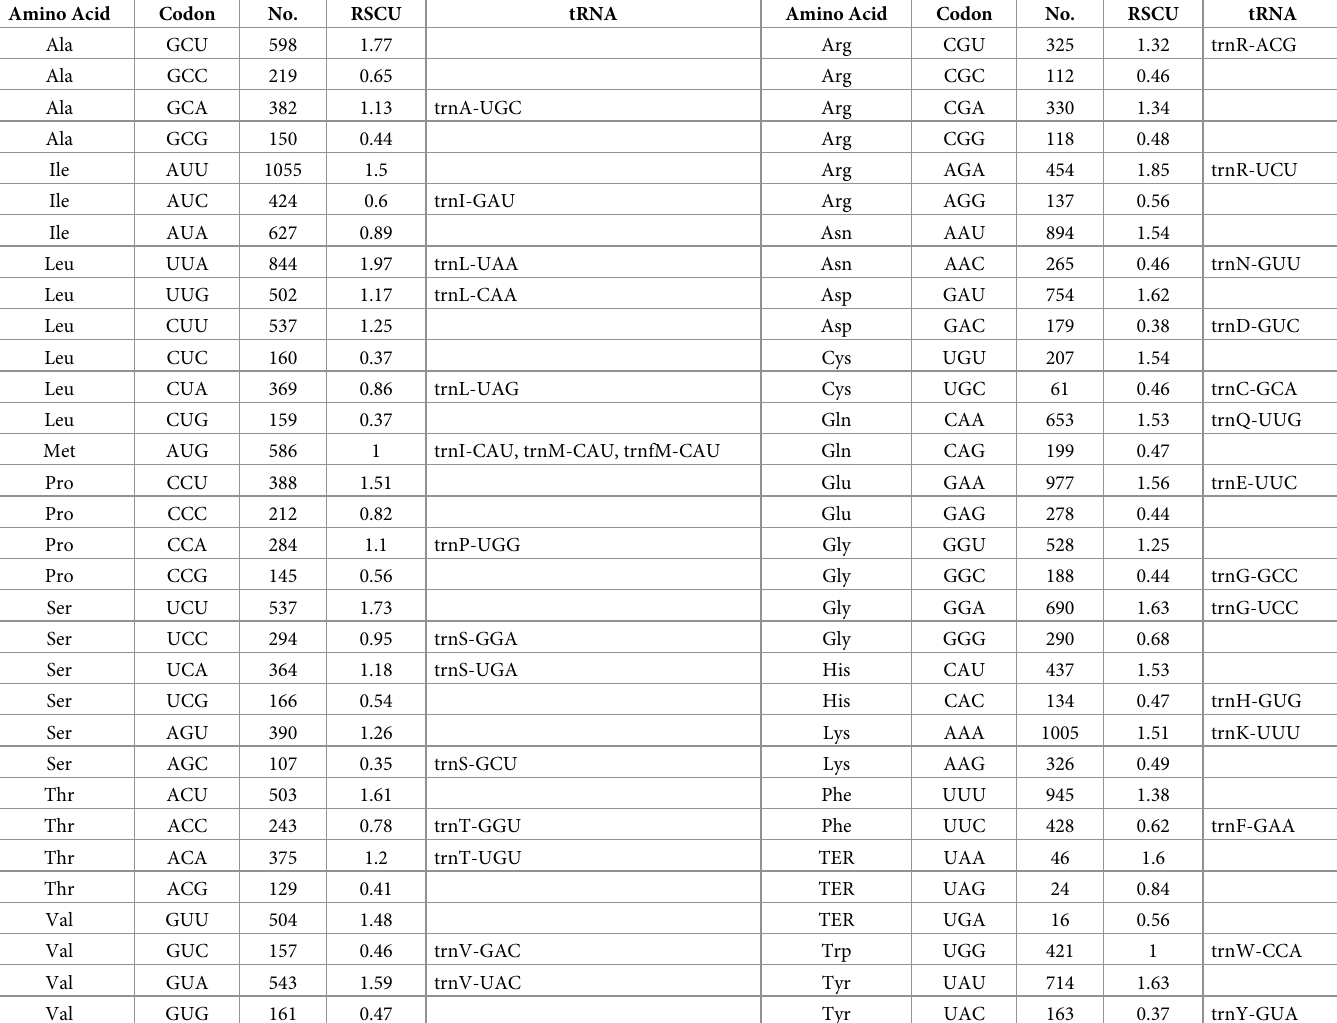
Table 2. Codon-anticodon recognition patterns and codon usage in the chloroplast genome of I . rubescens